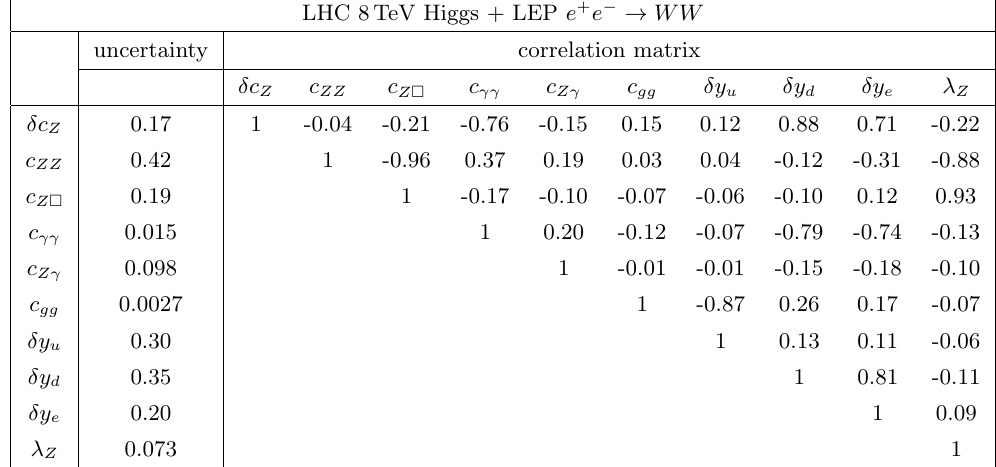
Table 8 . Current constraints on the Higgs basis parameters from ref. [23], obtained from the LHC 8 TeV Higgs measurements and LEP e + e To transform it into our framework we simply take (cid:14)y u we also set the central values to